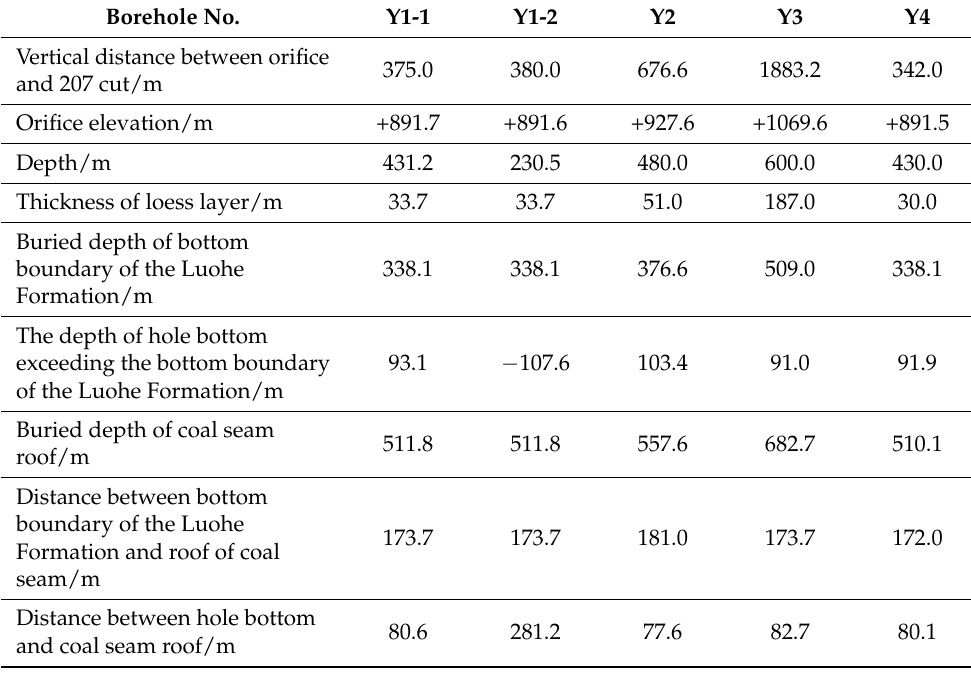
Figure 5. Borehole location. Table 1. Information on different boreholes.